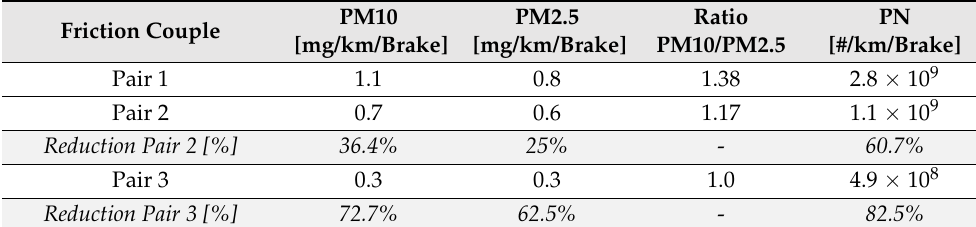
Table 8. Emission factors of the three different drum brake shoe compositions. PM10 Friction Couple [mg/km/Brake]